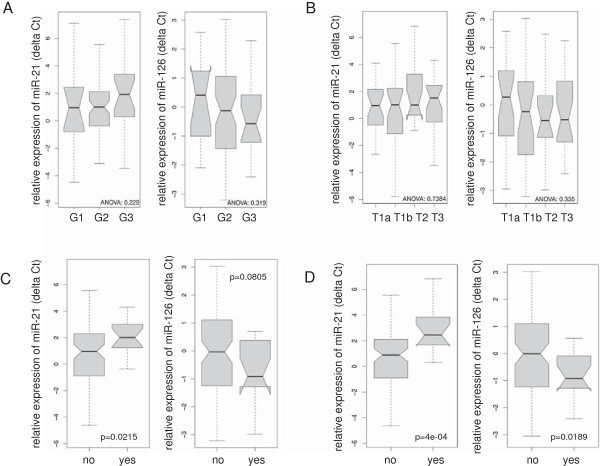
MiR-21 and miR-126 expression in association to clinical parameters. Box-Whisker-Plot: relative expression of miR-21 and miR −126 was analysed by the ΔΔCt method in RCC cases and subsequently the cases were divided into subgroups based on tumor grade (A), T stage (B) the presence of synchrone metastasis (C) or cancer related death (CRD) (D). P-values were calculated by students paired t-test (C and D) or by ANOVA (A and B).